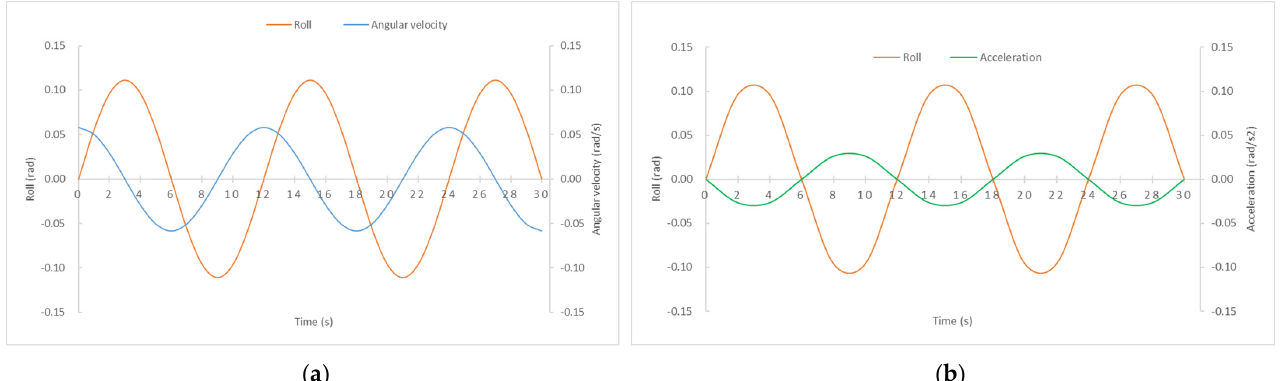
Figure 2. Rolling motion in calm waters and without resistance. ( a ) Rolling angle and angular velocity vs. time ( b ) Rolling angle and acceleration vs. time.